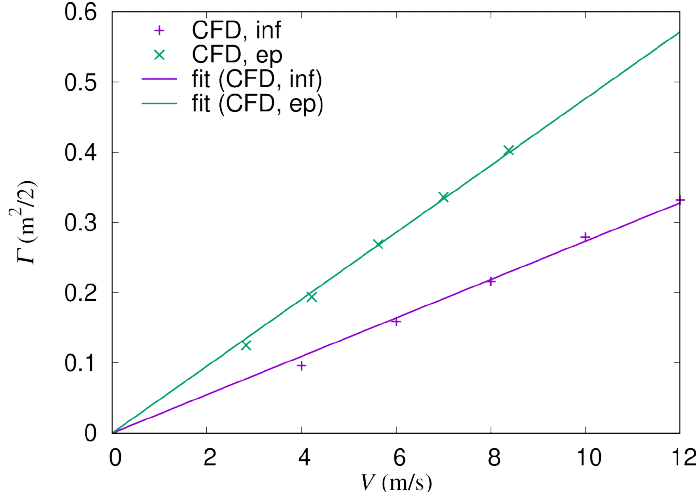
Figure A4. Γ obtained by CFD results and the fitting curves are